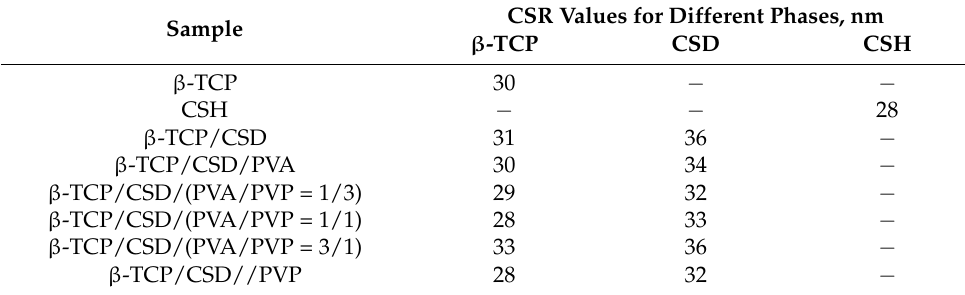
Table 1. CSR values of cement and initial powder